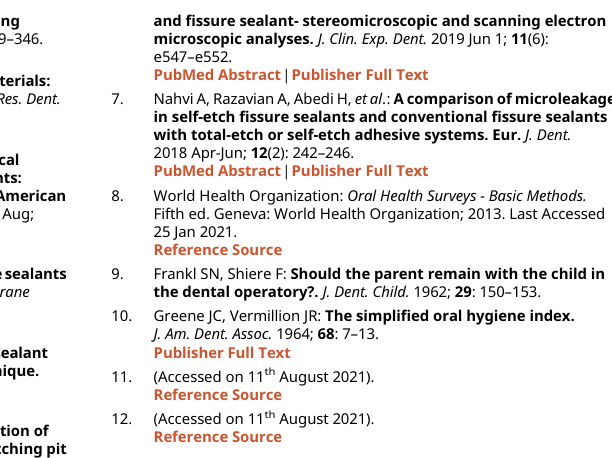
Figshare: Information sheet, consent form, accent form. https://doi.org/10.6084/m9.figshare.19196297. 22